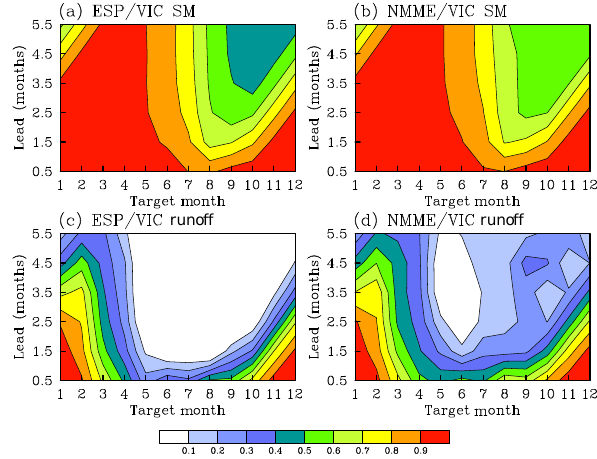
Figure 4. AC of ensemble mean hydrological forecasts from a climatology method (ESP/VIC) and the climate-model-based ap- proach (NMME/VIC) as a function of lead and target month for monthly mean soil moisture (a, b) and runoff (c, d) over the Yellow River basin during the period of 1982–2010. The soil moisture and runoff used for the verification are from VIC offline